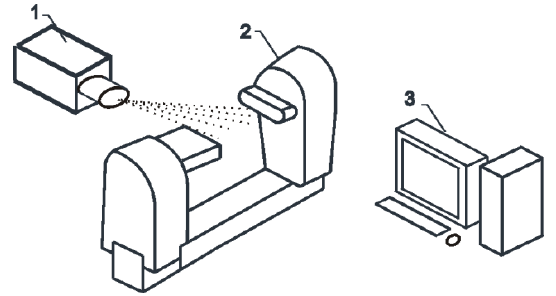
Figure 2. Test stand: 1—tested device, 2—Spraytec analyzer, 3—computer with the appropriate software.